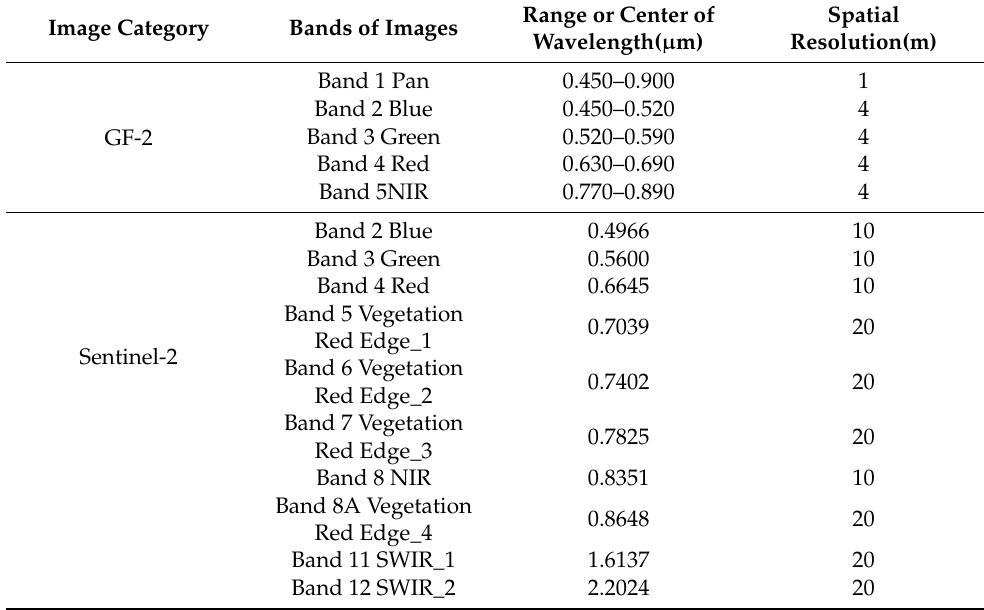
Table 3. Parameter information of bands for the GF-2 and Sentinel-2 images used in the